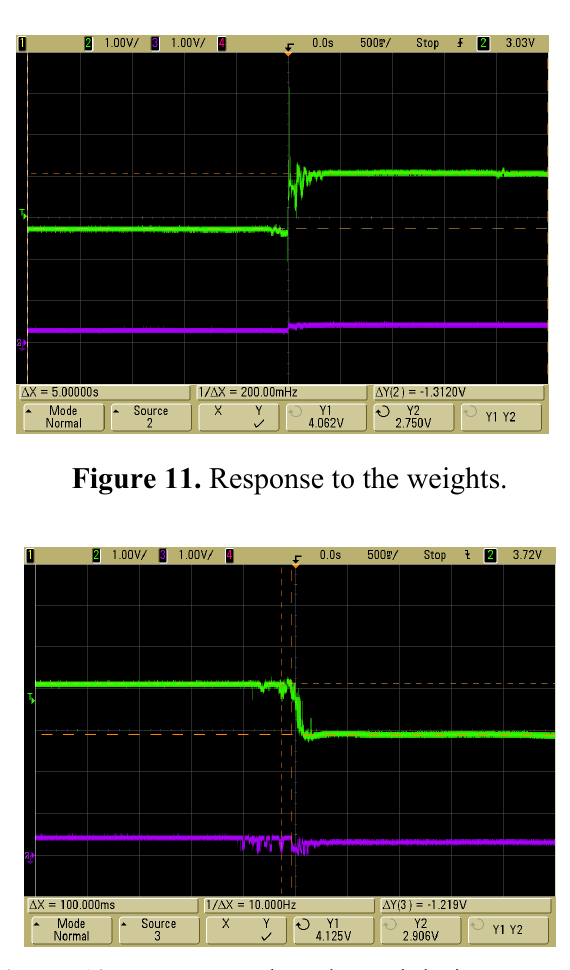
Figure 12. Response when the weight is removed.